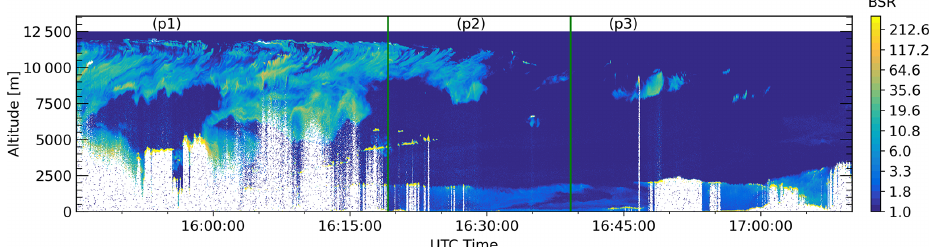
Figure 8. Backscatter ratio (BSR) measured by WALES lidar at 532nm (color coded). The measurement was performed during Mission 14 of the ML-CIRRUS campaign on 11 April 2014 over the United Kingdom and Belgium, depicting the outflow of a warm conveyor belt (WCB). The flight was conducted in a semi-Lagrangian manner, following the axis of the evolution of the system. p1, p2 and p3 depict clouds in different phases of aging from young to old, respectively.